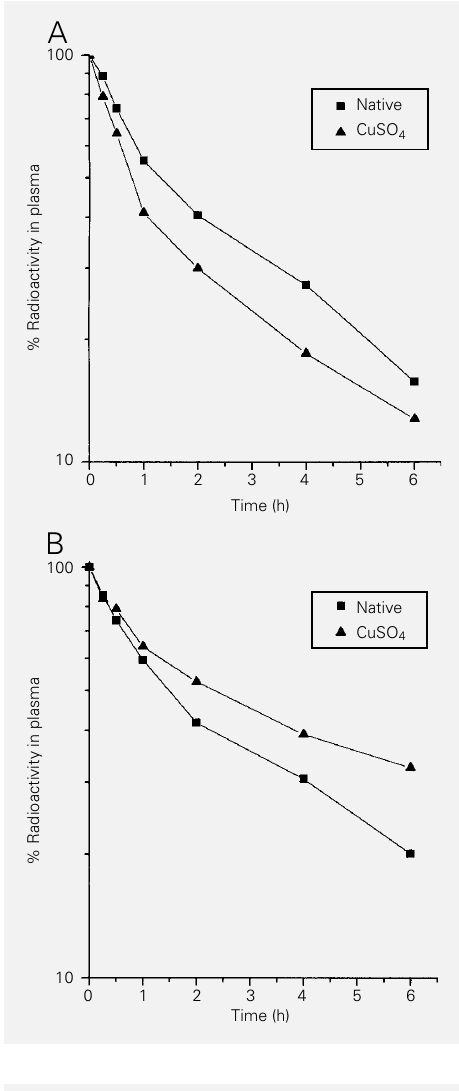
Figure 1 - Plasma decay curves of native 99m Tc-ß-VLDL and cop- per-oxidized 99m Tc-ß-VLDL in control (A) and hypercholester- olemic rabbits (B). Data are re- ported as means for 8-9 rabbits.